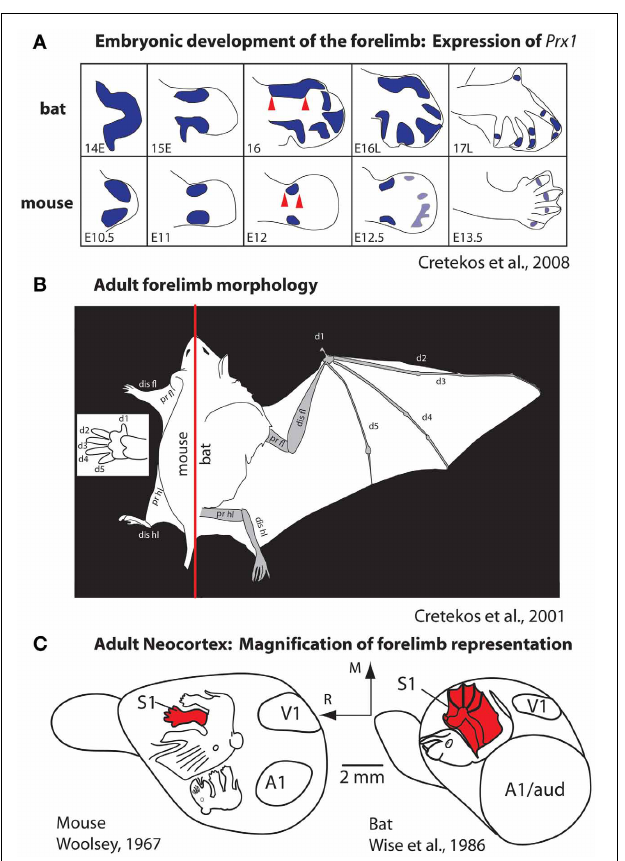
FIGURE 6 | Development (A) and morphology (B) of the forelimb, and the representation of the forelimb in somatosensory cortex (C) in mice and bats. (A) At middle stages of forelimb development the expression of Prx1 (purple) is expanded in the distal forelimb (red arrows). This alteration, among a number of other molecular changes, accounts for the radical differences in the rat forepaw compared to the bat wing (B) . These morphological differences in the distal forelimb in addition to differential use of the paw vs. wing have likely contributed to the differences in size and internal organization of the forelimb representation in S1 (C) . Figures are modified from Cretekos et al. (2001, 2008); Woolsey (1967), and Wise et al. (1986). Other conventions as in previous